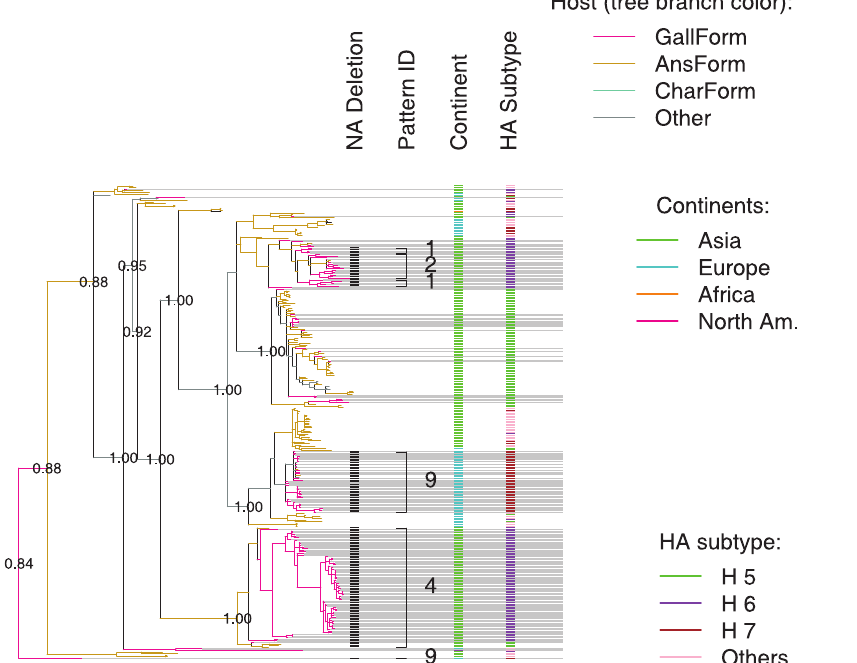
Figure 2. Phylogenetic tree of a subset of N1 sequences and distribution of S D NA patterns (constructed in MrBayes 3.1.2). Values at nodes show estimated posterior probabilities for bipartitions. Branch colors indicate host order. Genes of isolates from gallinaceous hosts are shown by tree branches with extended grey lines. The first column from the left shows a black dash for each isolate with S D NA. The second column shows the deletion pattern ID. Sequences with the same deletion pattern are denoted by square brackets numbered with pattern ID. The third column shows which continent each isolate was from and the fourth column indicates the HA subtype of each isolate.